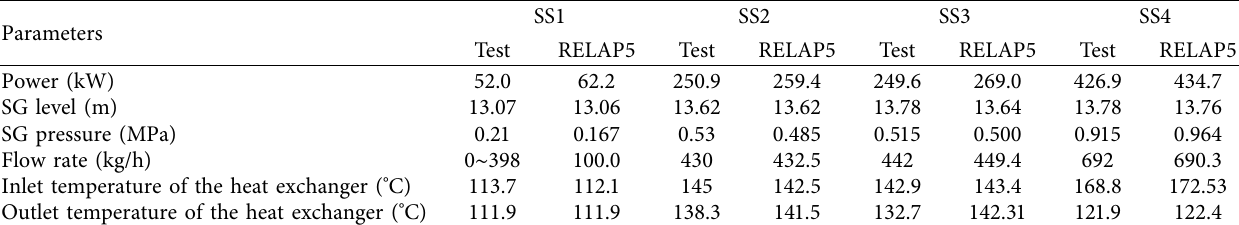
Table 2: Comparisons between tests and RELAP5.